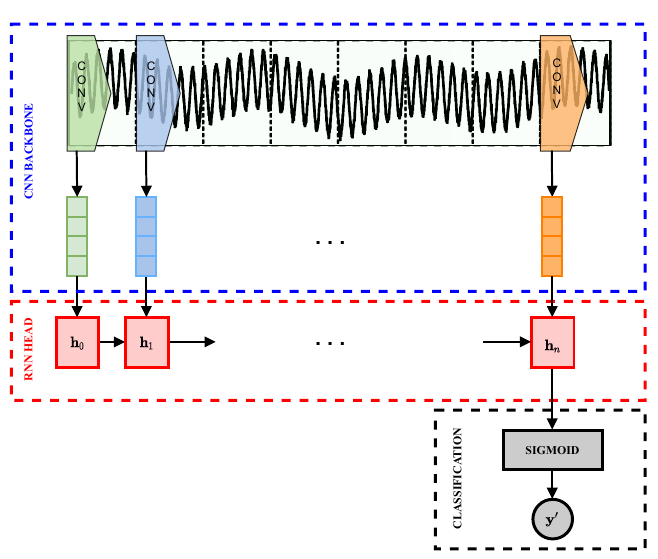
Figure 6. Proposed black-box